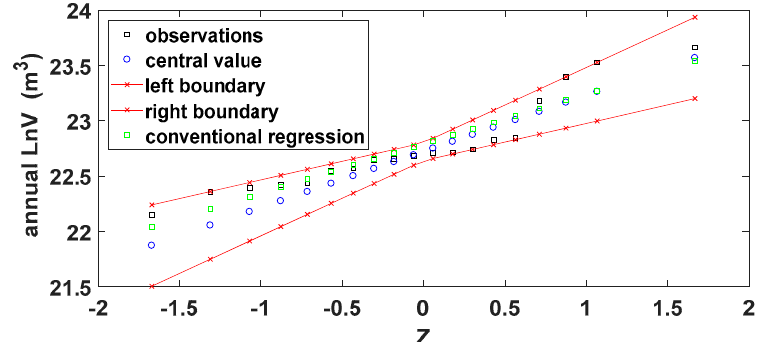
Figure 4. Observed data, fuzzy and conventional (crisp) regression between the annual cumulative logarithmic streamflow values and the standardised random variable Z .